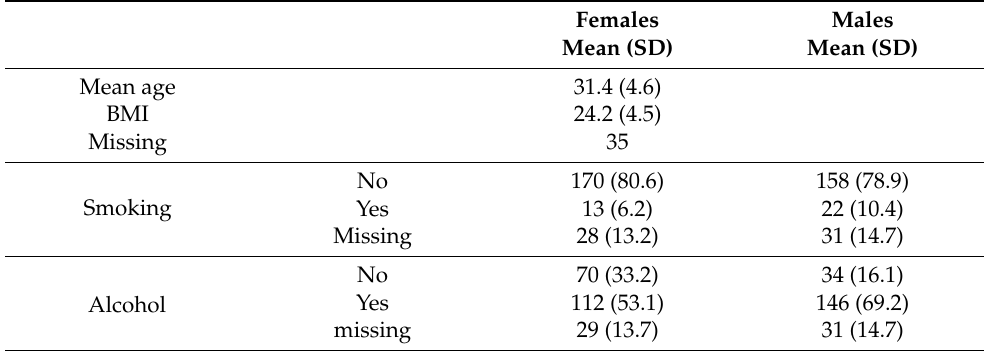
Figure 1. Of the 236 couples initially included in the study, 25 never received any form for treatment. For the remaining 211 couples, 511 cycles were included. For 146 of the patients, a baseline DFI was obtained. From these patients, 352 cycles were available. For 197 of the couples, DFI was analyzed in minimum two different samples. Of these, 126 couples received fertility treatment. Table 1. Basic characteristics for all